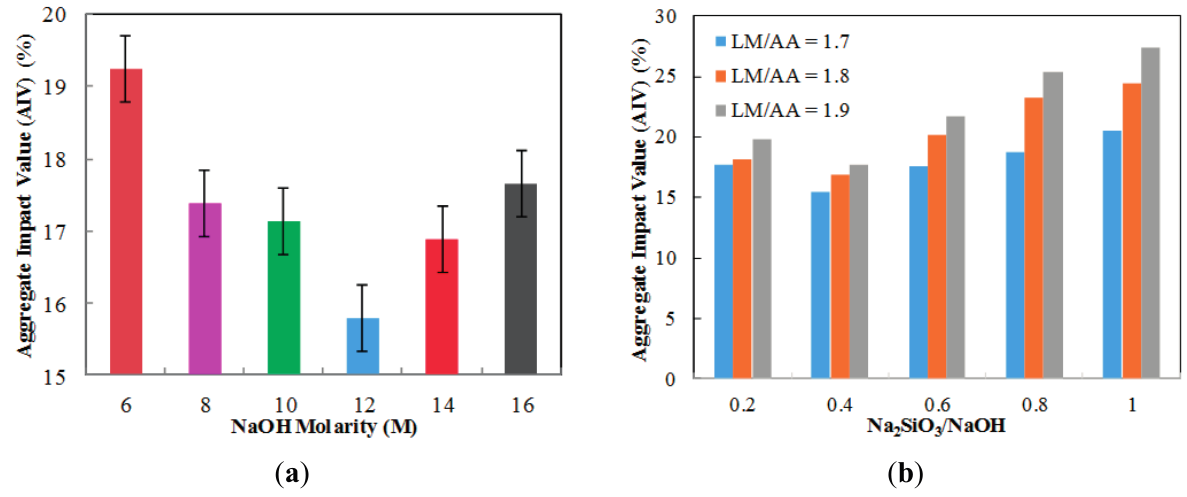
Figure 3. The aggregate impact value (AIV) of ALGA at ( a ) various NaOH molarity; ( b ) various LUSI mud/Alkaline activator (LM/AA) ratio and Na 2 SiO 3 /NaOH